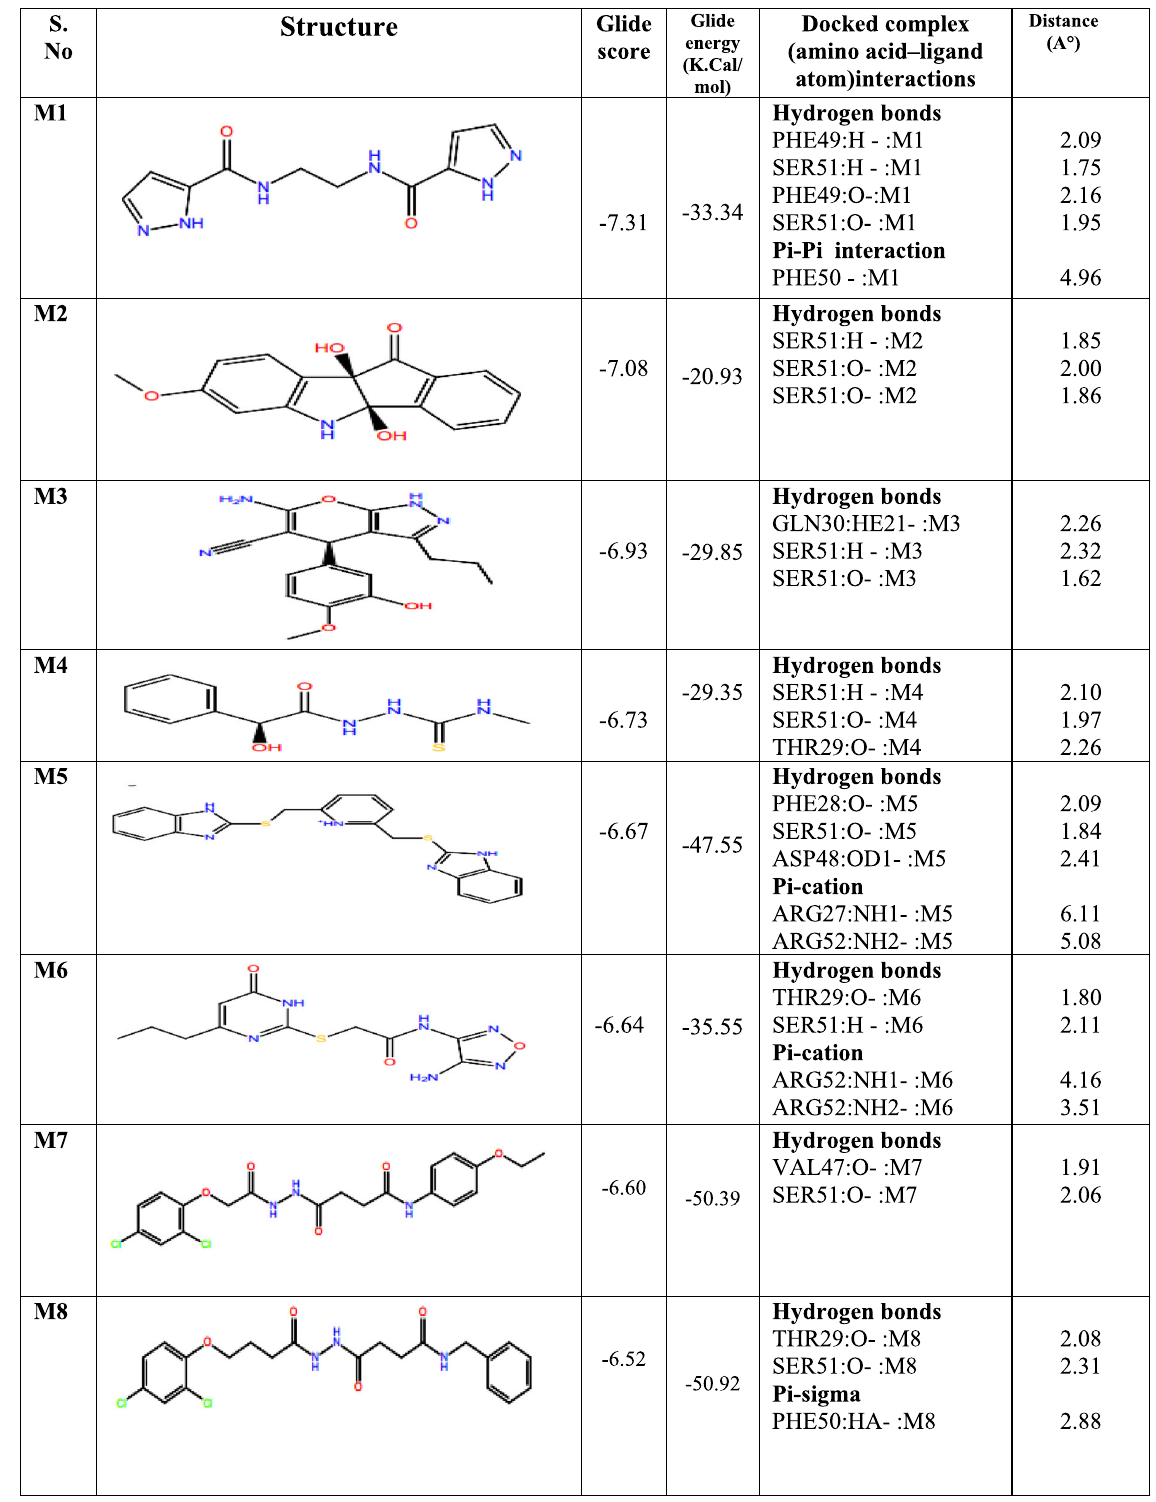
Table 5 The ligand structures and the intermolecular interactions with Rab39a